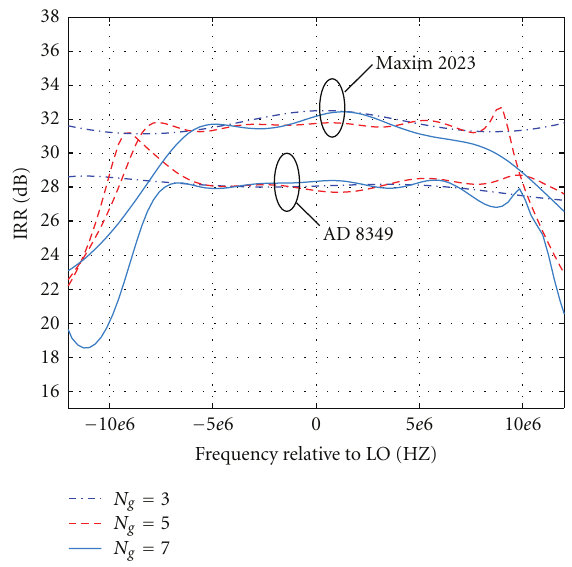
Figure 12: Comparison of averaged FE IRR versus frequency for di ff erent imbalance filter lengths. LO frequency = 1.5GHz.